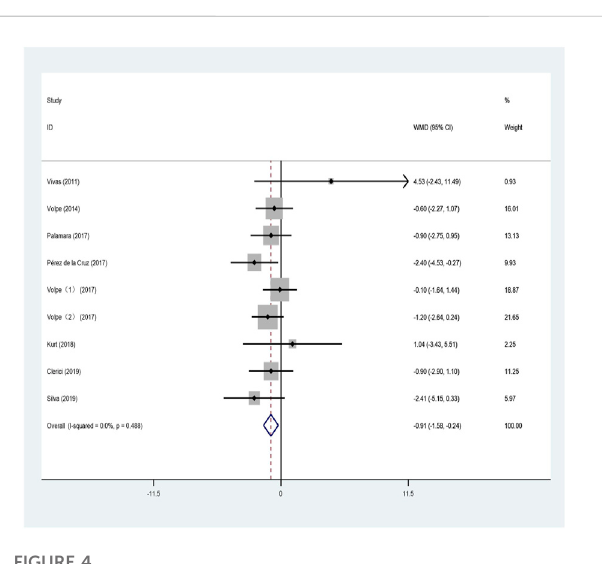
Effects of aquatic exercise on walking ability of PD